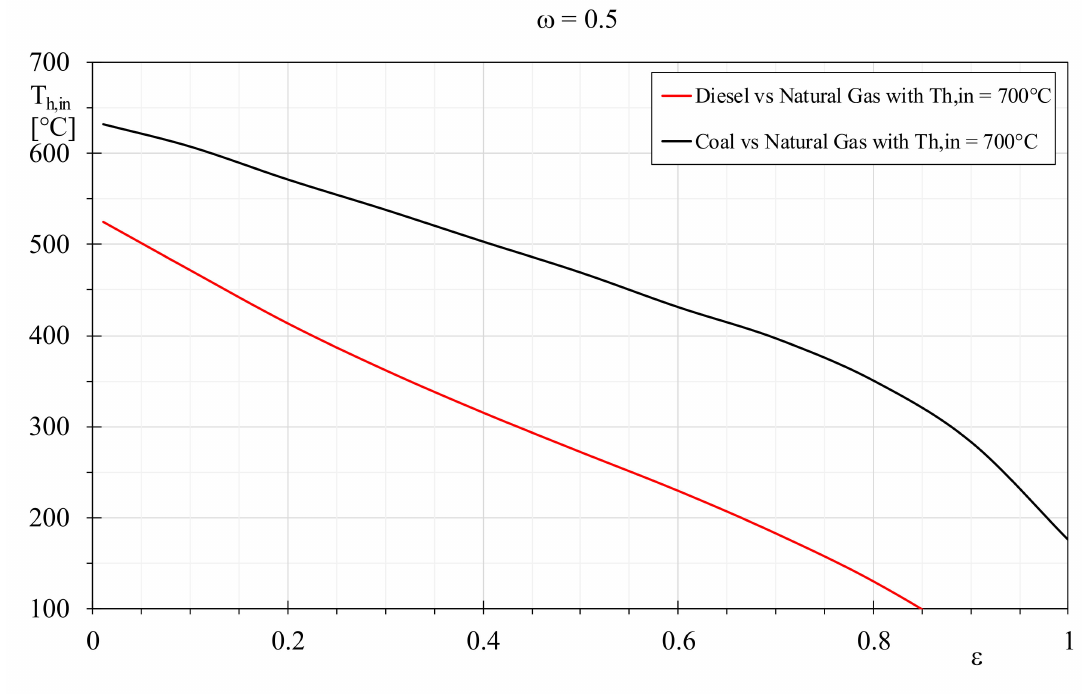
Figure 12. Coal and Diesel flue gas temperatures required to achieve the same EQI of Natural gas with combustion products temperature of 700 ◦ C, related to the heat exchanger efficiency and by setting ω =